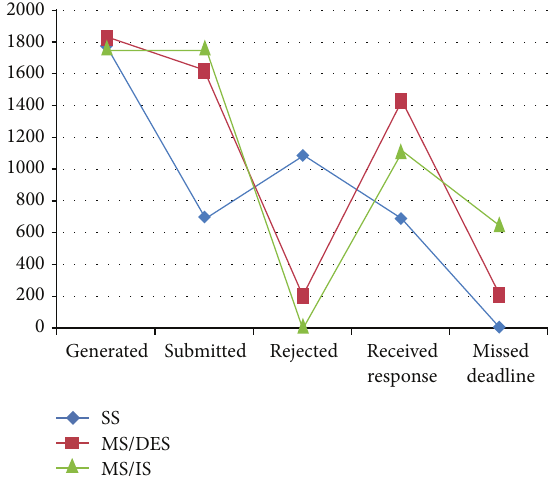
Figure 10: Results of various performance metrics related with query and response numbers for a larger deadline.